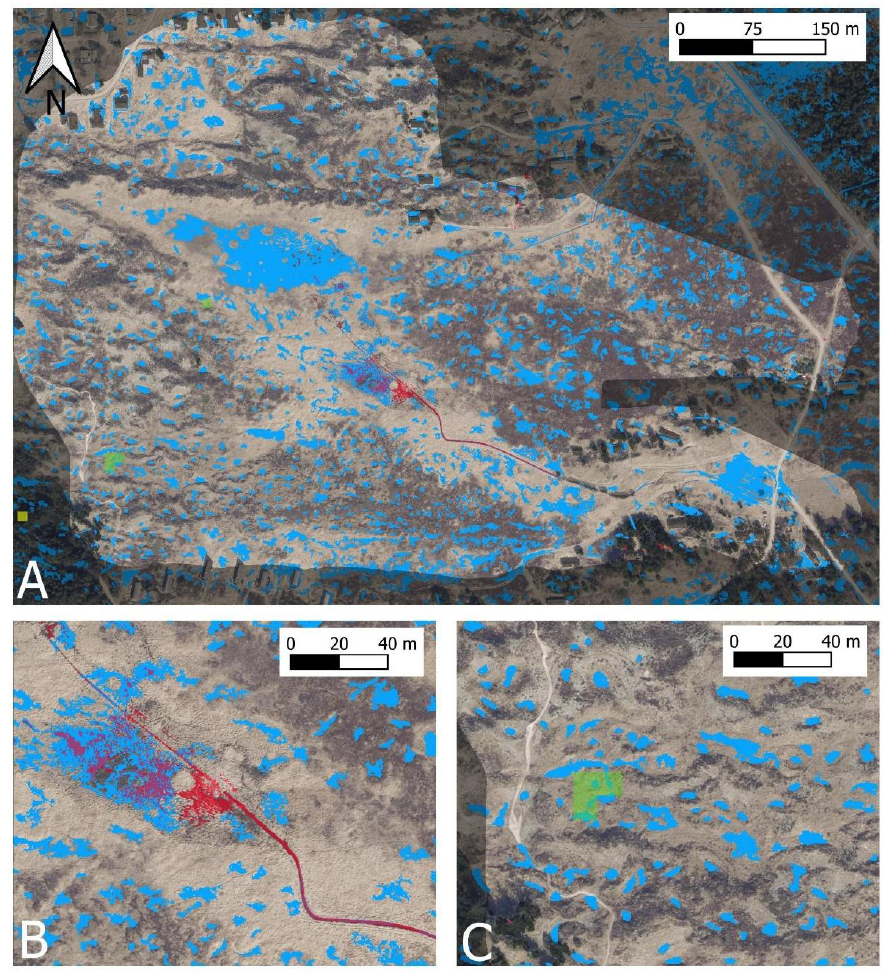
Figure 5. Bluespot areas (blue, threshold 10 mm), UAS SWE (red) and satellite SWE (green: Sentinel-1, 28-02-2022, yellow: Sentinel-2, 26-02-2022) for the entire Rødehus Kanal area ( A ) and two zoomed-in sub-areas ( B , C ). Background is spring airborne imagery and grey shading indicates areas without UAS flooding status.